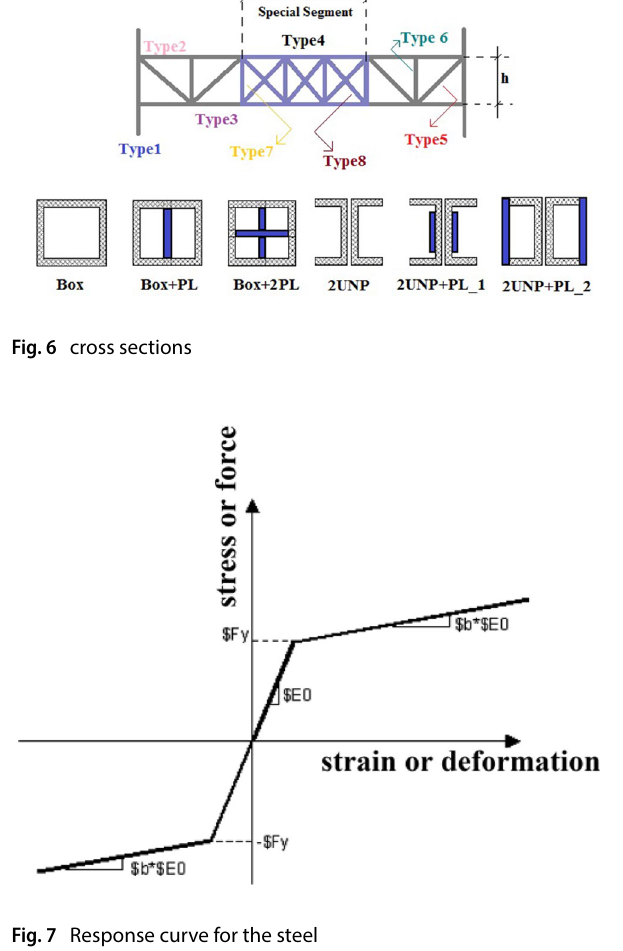
Fig. 7 Response curve for the steel